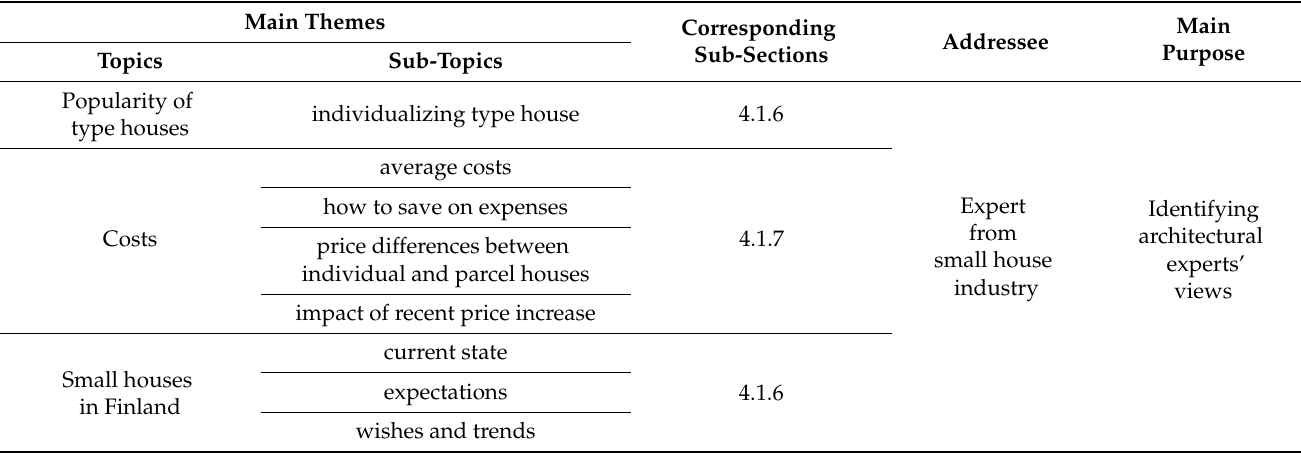
Table 2. The main themes, addressee, and main purpose of the interview questions (Appendix A.1).